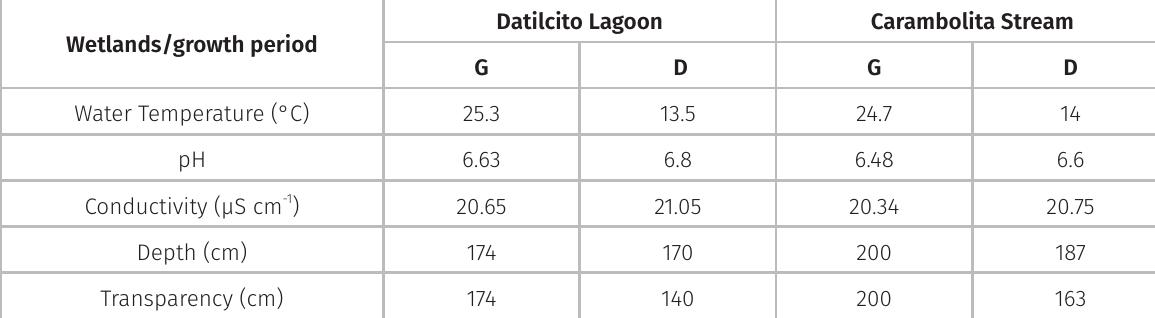
Figure 1. Study area in the Iberá wetlands at the Northeast of Argentina, supporting invertebrate communities associated to the S Egeria najas and the FR Pontederia azurea macrophytes. Sites are shown with latitude and longitude coordinates. A: Carambolita stream (28° 24’ 20.04’’ S - 57° 39’ 32.74” W). B: Datilcito lagoon (28° 25’ 52.50’’ S - 57° 38’ 20.22” W). FR: floating- leaf-rooted macrophyte, S: submersed macrophyte.